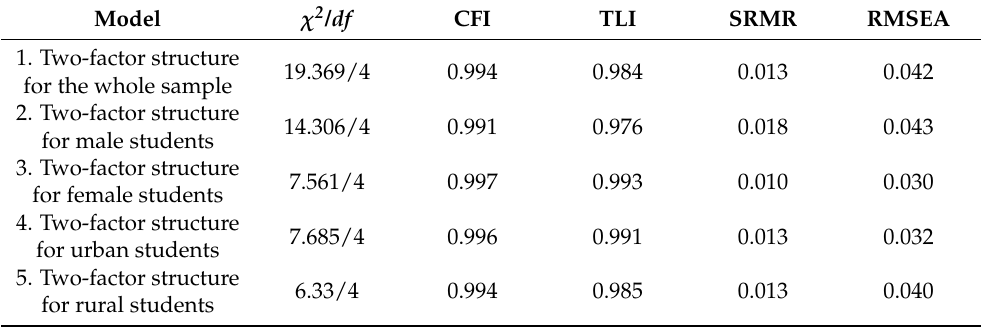
Table 4. Parcelling CFA Model Fit of the CFPS-2018 Participants’ Depressive Traits ( n = 2173).